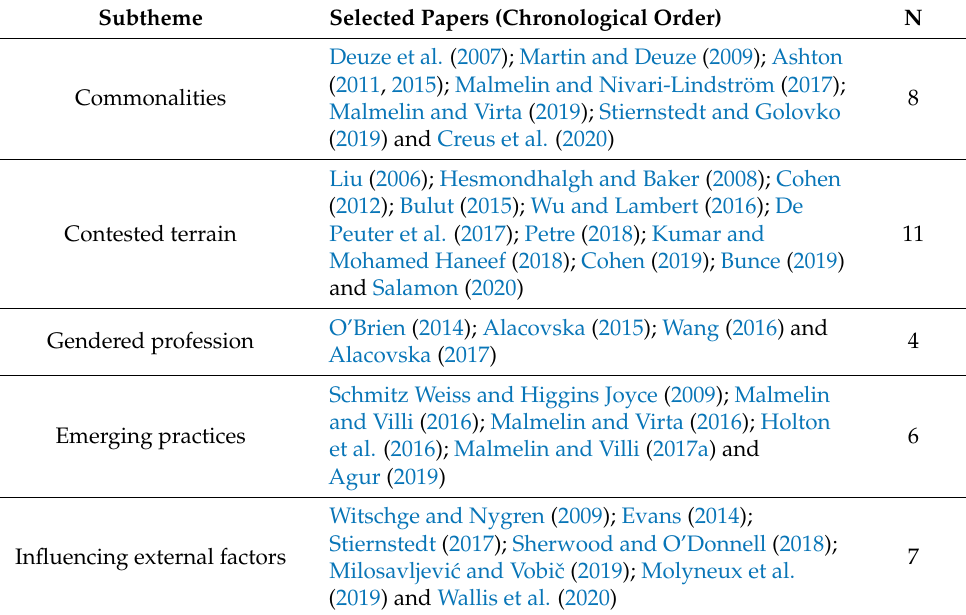
Table 1. Papers selected for this